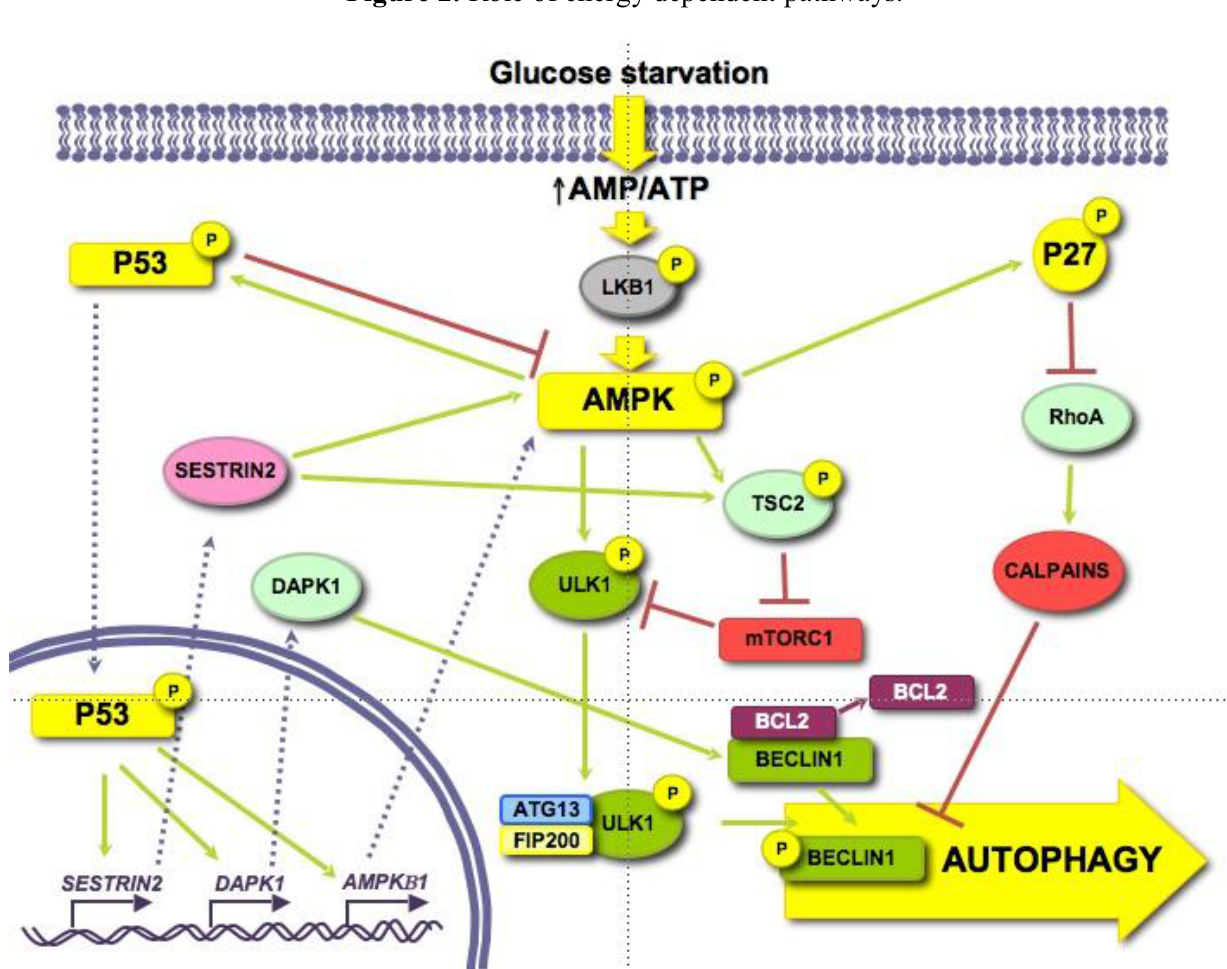
Figure 2. Role of energy dependent